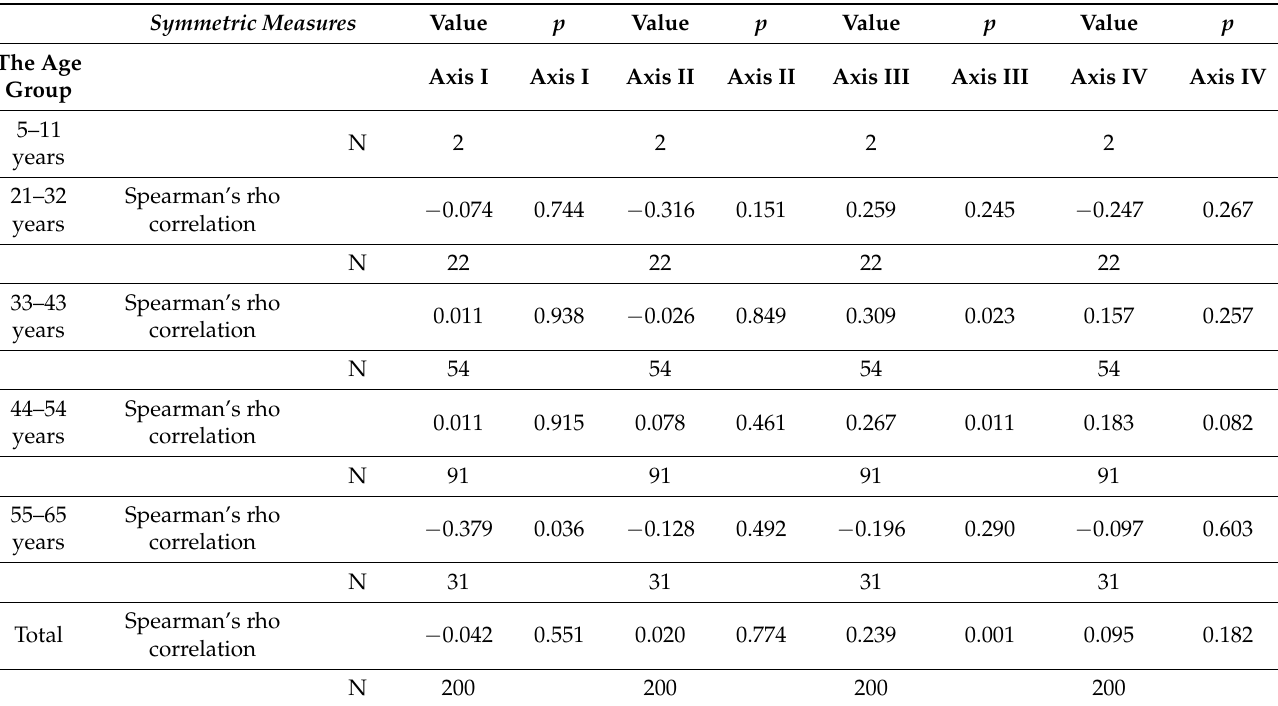
Table 1. The effect of contact with the stressor on the incidence of Axis I–IV symptoms in the age